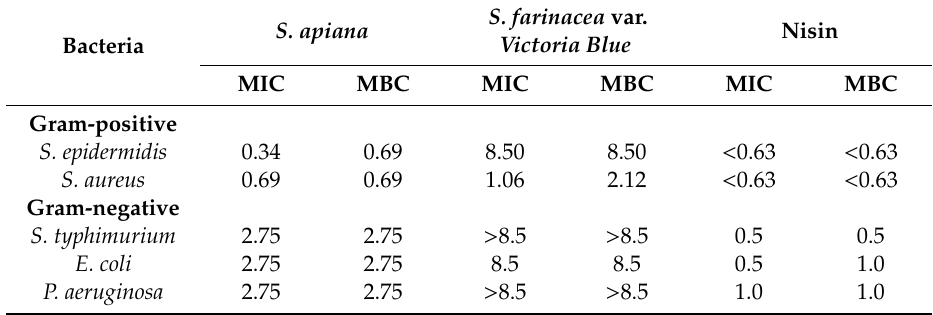
Table 3. Minimum Inhibitory Concentration (MIC) and Minimum Bactericidal Concentration (MBC) of S. apiana and S. farinacea var. Victoria Blue decoctions and nisin against selected test